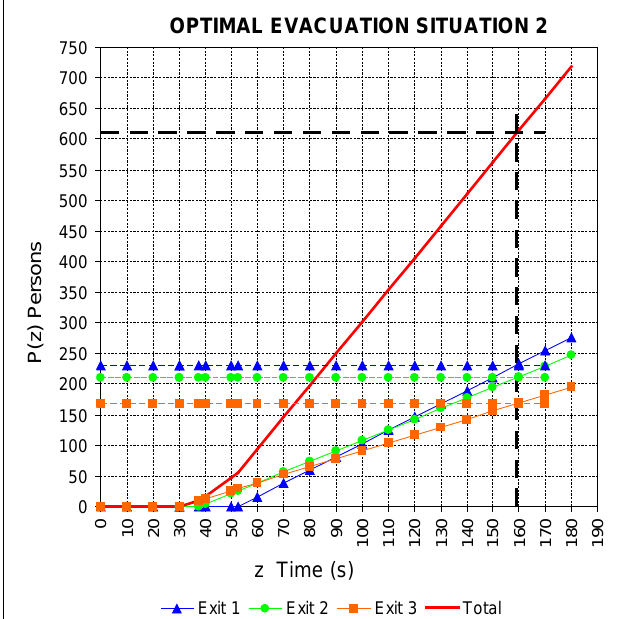
Figure 6. ”Solution case